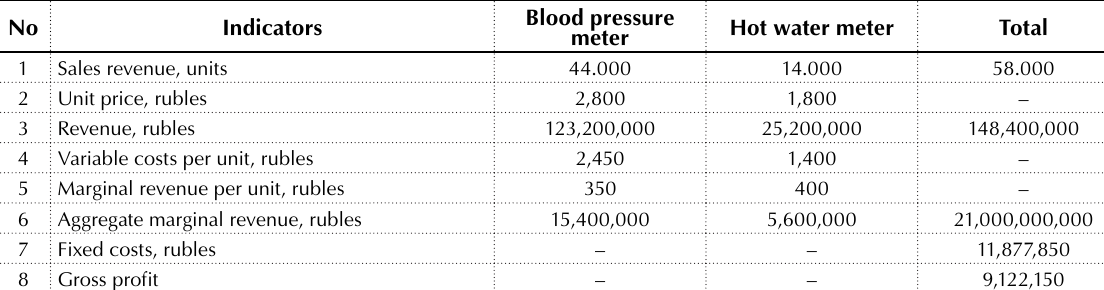
Table 4. Information characterizing the activity of the enterprise in case of refusal to make the product called electricity